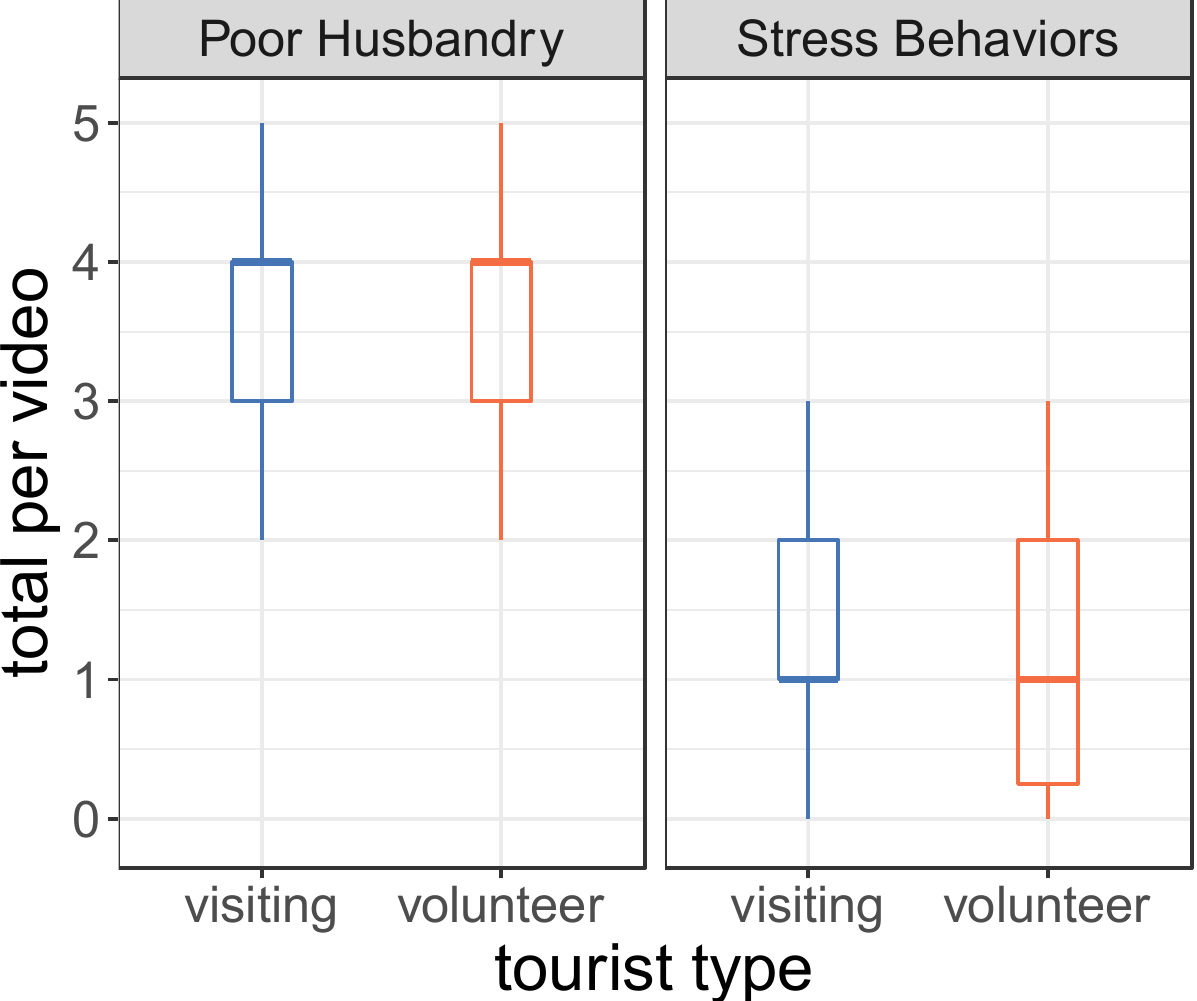
Figure 2. Evidence of poor husbandry and cub stress by tourist type. The thick horizontal lines, colored boxes, and whiskers (standard box-plots) indicate, respectively, the median, central 50% bulk of the data (interquartile range), and the outer percentile of observed poor husbandry practices (6 max) and cub stress behaviors (4 max) in each video ( n = 49). Kruskal–Wallis tests indicated no difference in these variables by tourist type (both p ’s > 0.6).